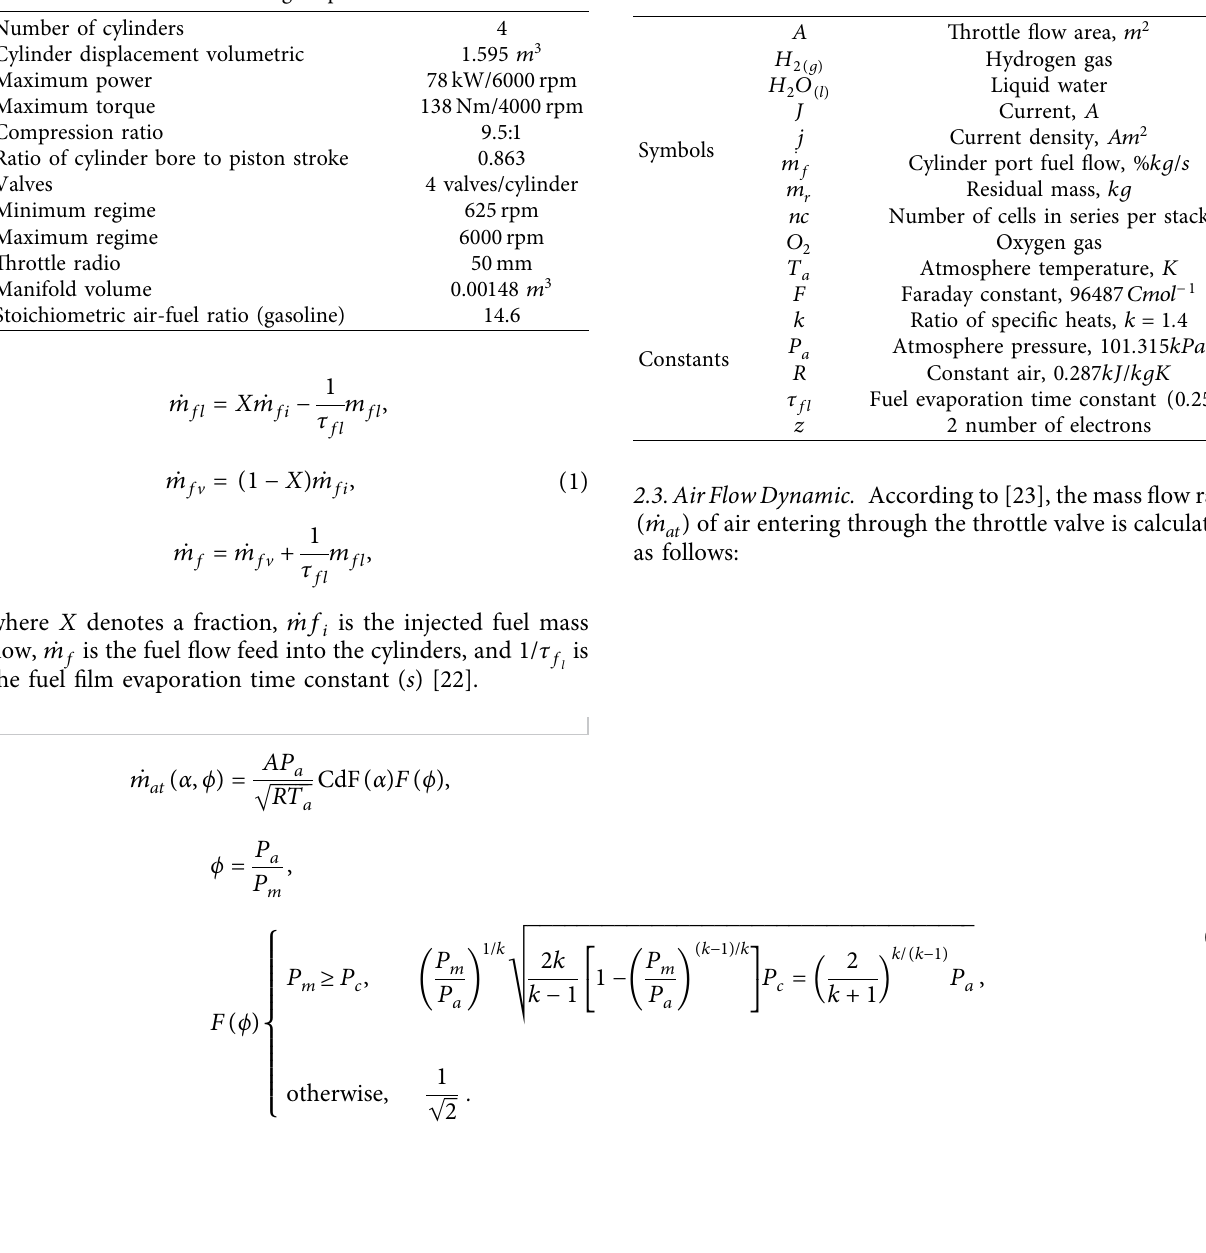
Figure 1: IC engine and electrolyzer. Table 1: IC engine parameters. Table 2: